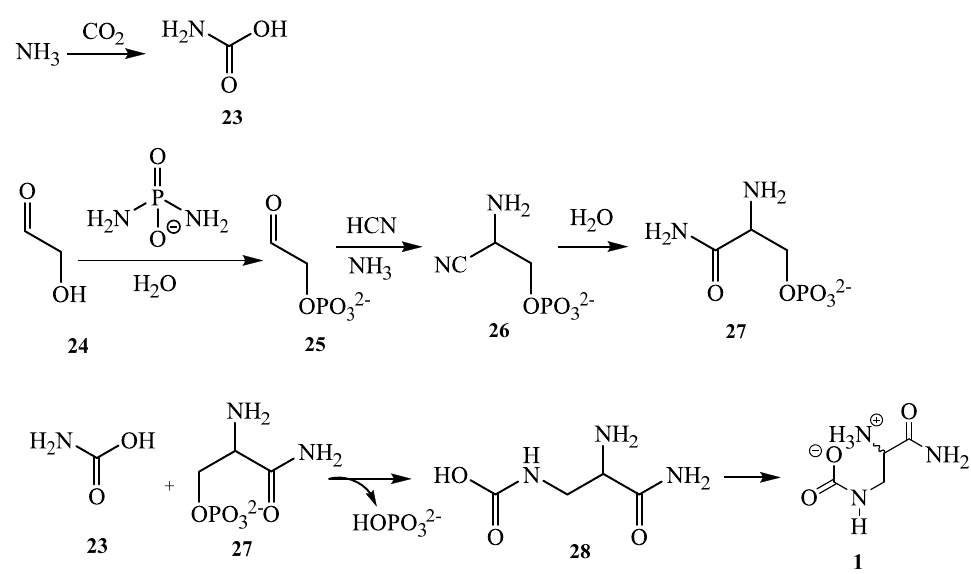
Figure 3. Proposed biosynthetic pathway of compound 1 .